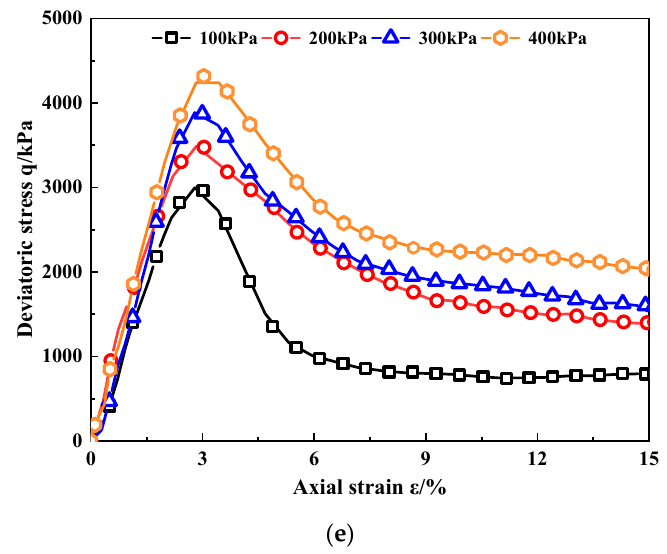
Figure 4. Deviatoric stress–strain curves of MCRA. ( a ) MCRA0. ( b ) MCRA0.5. ( c ) MCRA1.0. ( d ) MCRA1.5. ( e ) MCRA2.0.